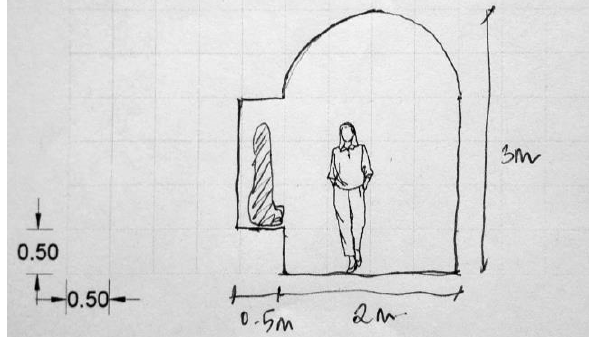
Figure 14. The section drawn by one of the participants